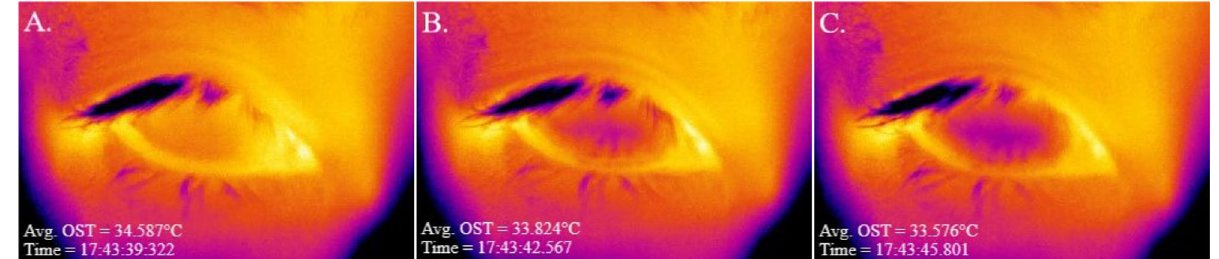
Figure 2. A series of screen captures of an OST video recording ( A ) immediately upon full eyelid opening, ( B ) the middle of the interblink period, and ( C ) the last frame before the start of eyelid closure. Darker (purple) region indicates area of